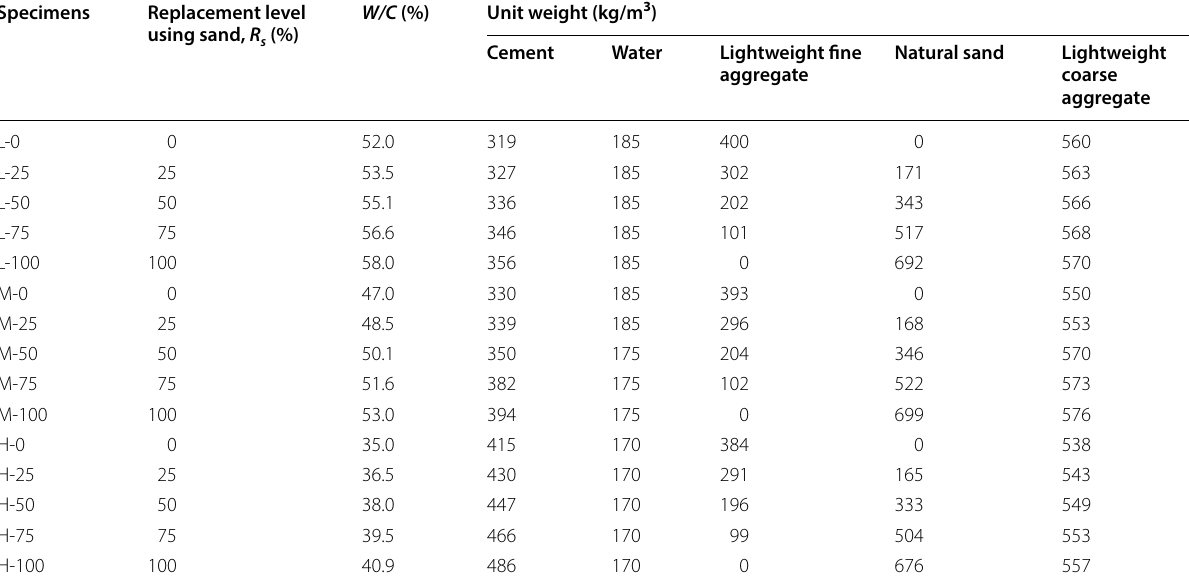
Table 2 Mixture proportions of the concrete